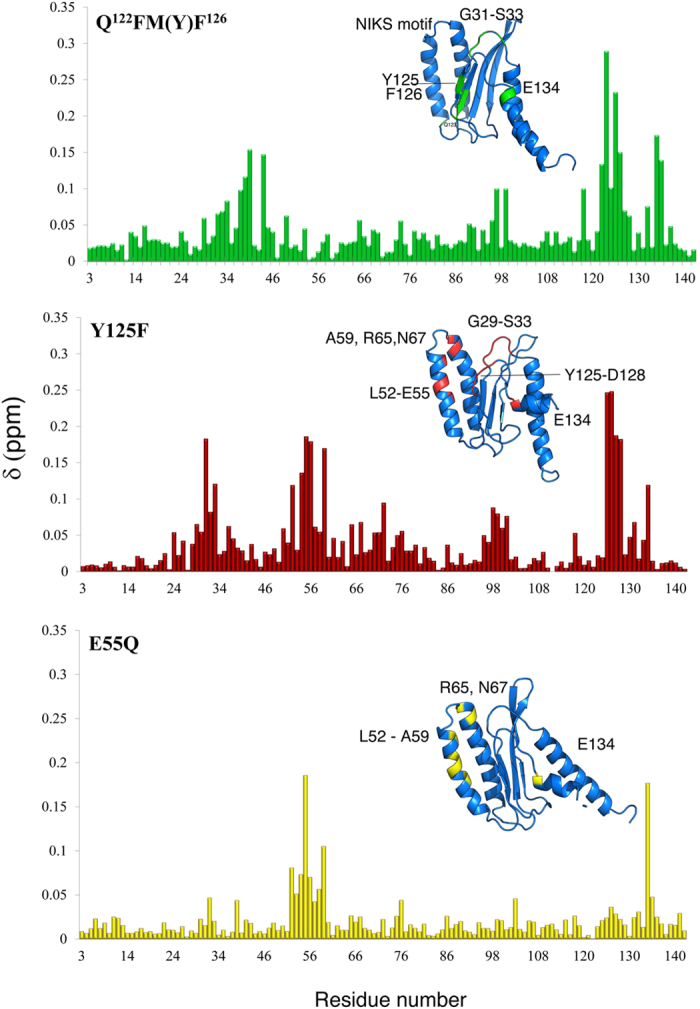
Chemical shift perturbation induced to the backbone amide signals between wild-type and mutant eRF1 N-domains, (A) Q122FM(Y)F126 (B) Y125F and (C) E55Q. Location of residues that experience significant perturbations upon introduction of mutation are highlighted on the structure (insert).